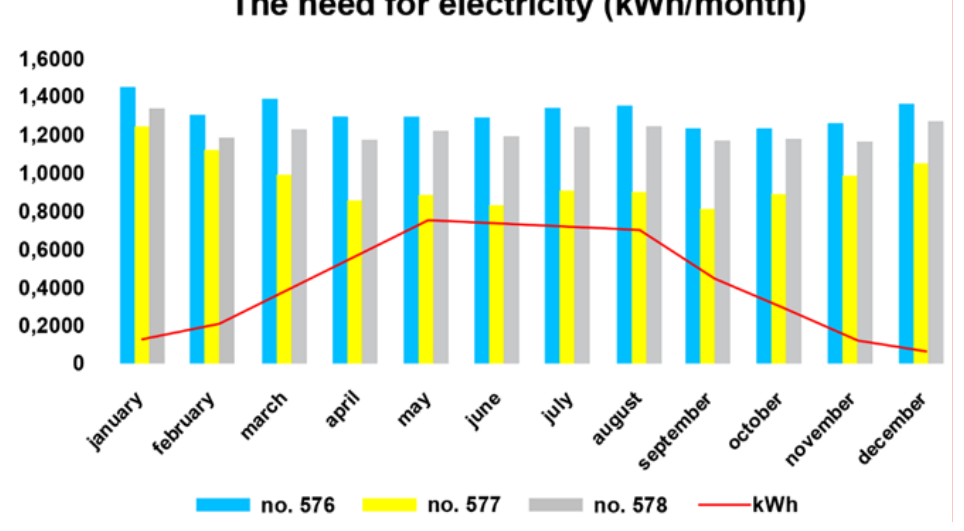
Figure 19. Electricity consumption by months of the year.